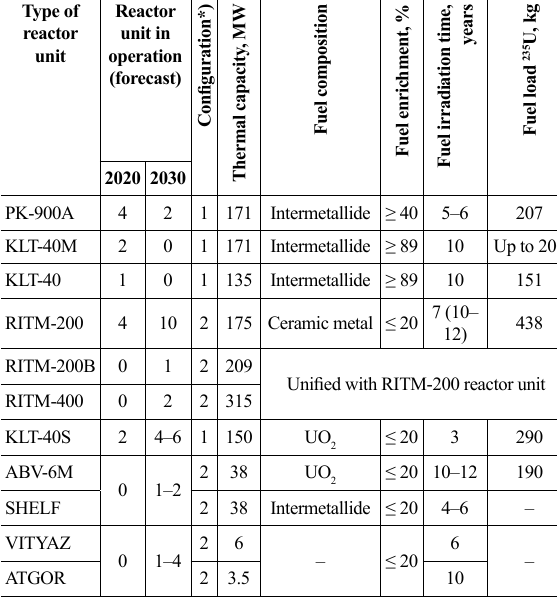
Table 1. Parameters of reactor units operated (planned for oper - ation) in the